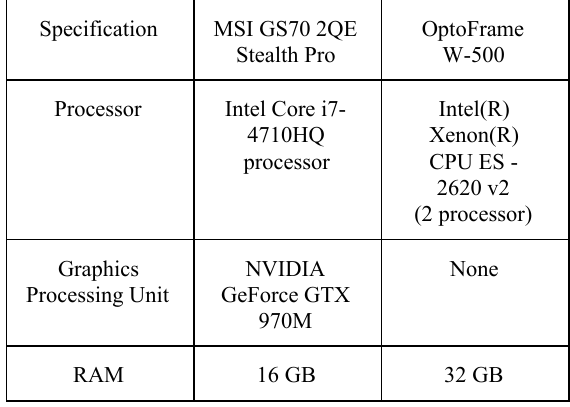
Table 2. Specifications of the computers used for the